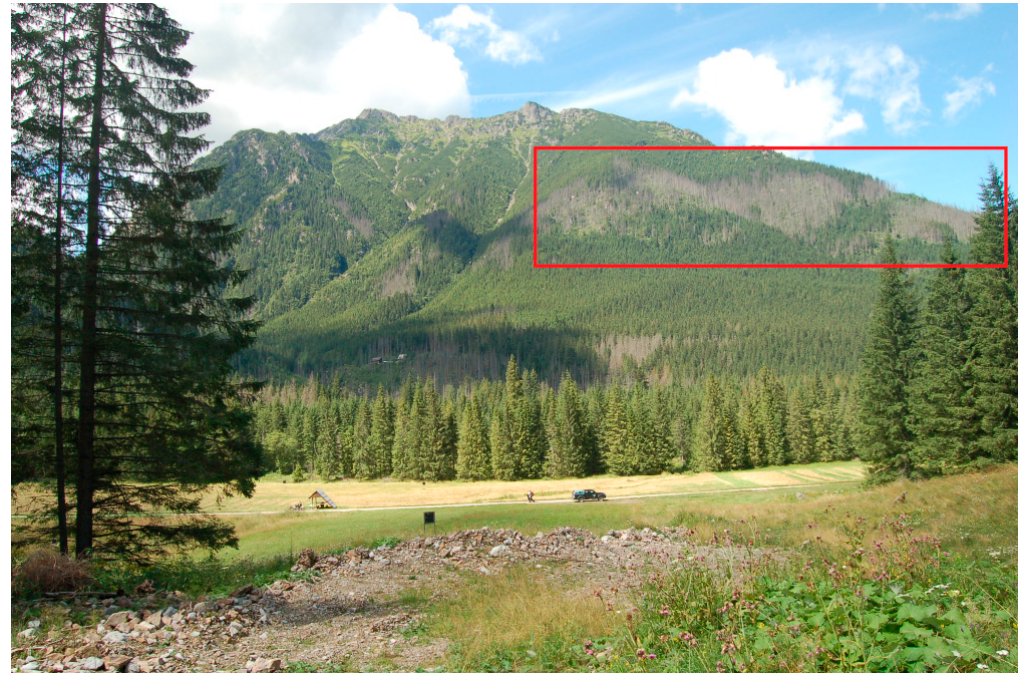
Figure 1. Example of bark beetle–infested trees in the High Tatra Mountains National Park, Slovakia. Bark beetle-infested trees are in the red rectangle (Photo: Pavel Mezei.).